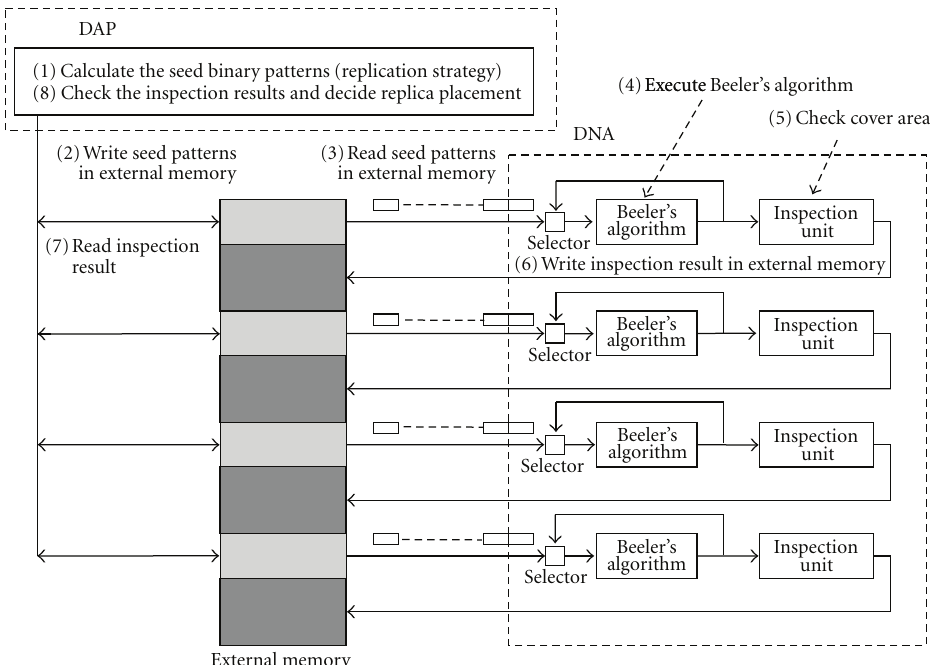
Figure 7: Block diagram of DAPDNA-2 implementation and execution